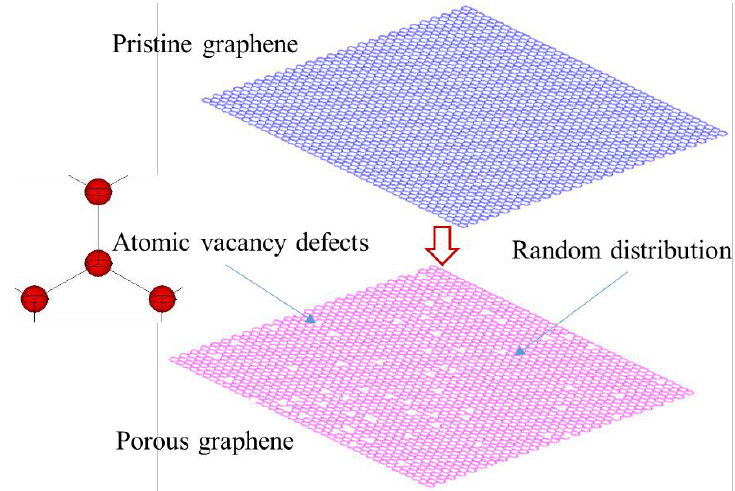
Figure 8. Schematic of porous graphene (the percentage of atomic vacancy defects is 1.5%).